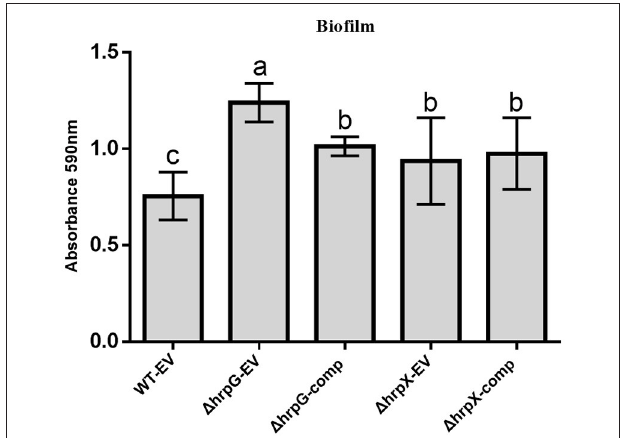
FIGURE 2 | Effects of hrpG and hrpX genes on Acidovorax citrulli biofilm formation. The biofilm formation of A. citrulli in 24-well multi-dishes as quantified using crystal violet staining. WT-EV, wild-type strain Aac5 transformed with empty vector, pBBRNolac-4FLAG; 1 hrpG-EV , hrpG mutant transformed with empty vector, pBBRNolac-4FLAG; 1 hrpX-EV , hrpX mutant transformed with the empty vector pBBRNolac-4FLAG; 1 hrpG-comp ,